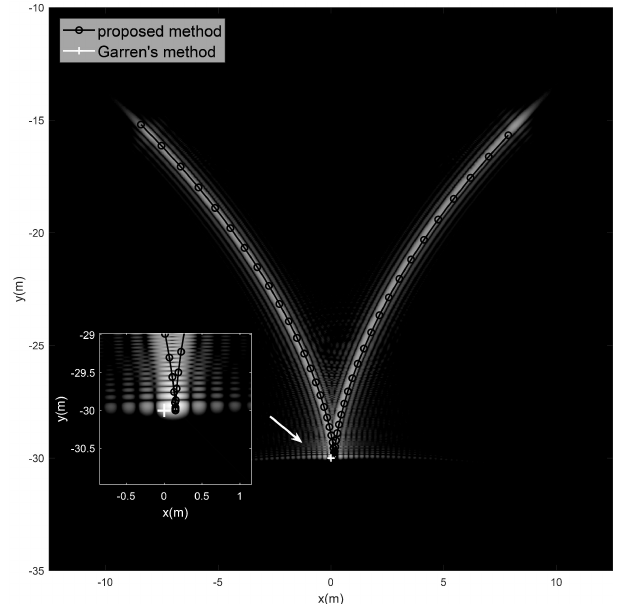
Figure 30. The SAR image superimposed with image traces calculated with linear SAR and CSAR model. The target moves from left to right at 2